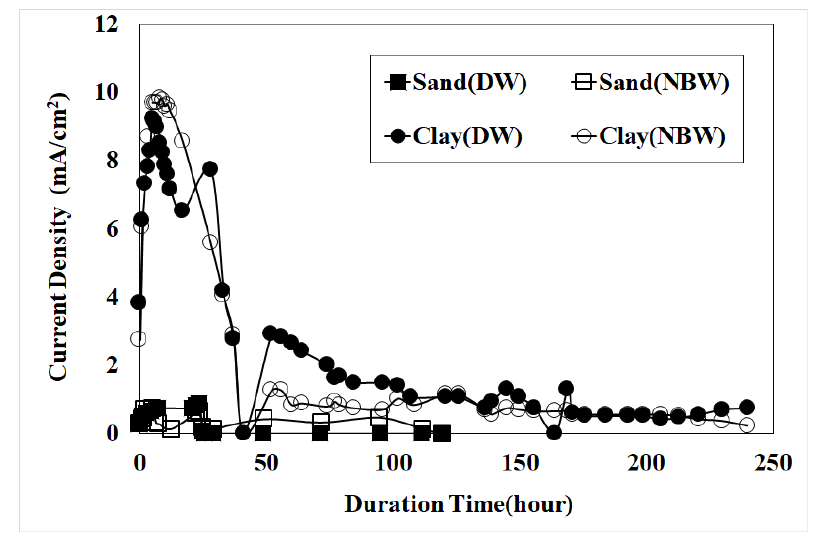
Figure 7. Current density.